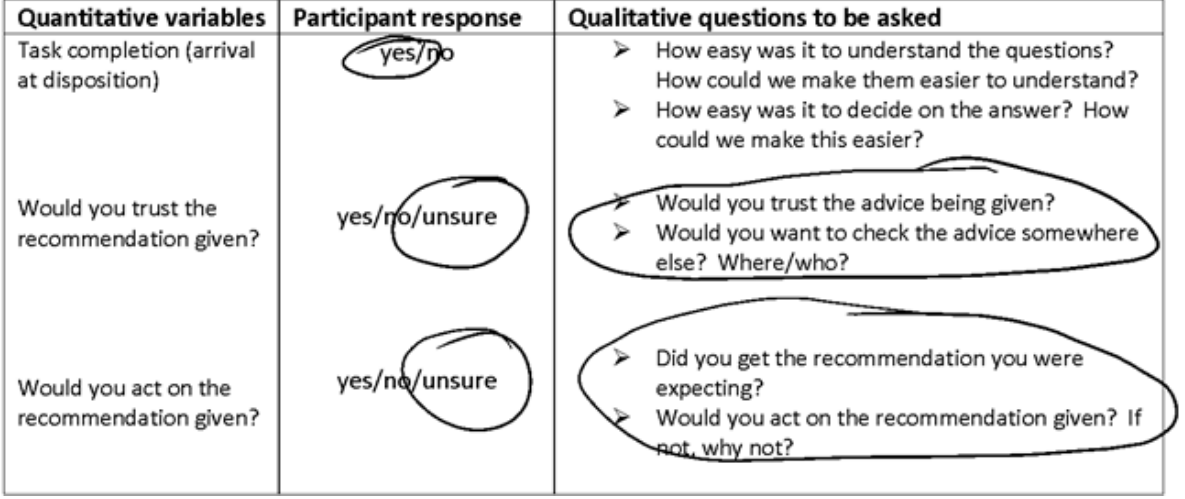
Figure 4. An extract from a joint visual display showing how a researcher uses responses to quantitative data to guide qualitative data collection in real